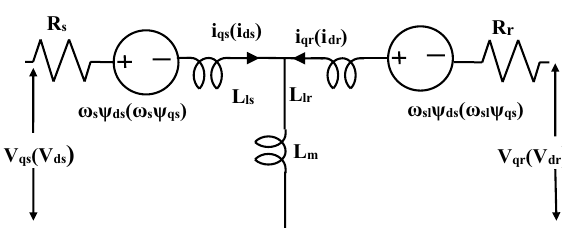
Fig. 1 Per phase equivalent circuit of IM in d-q